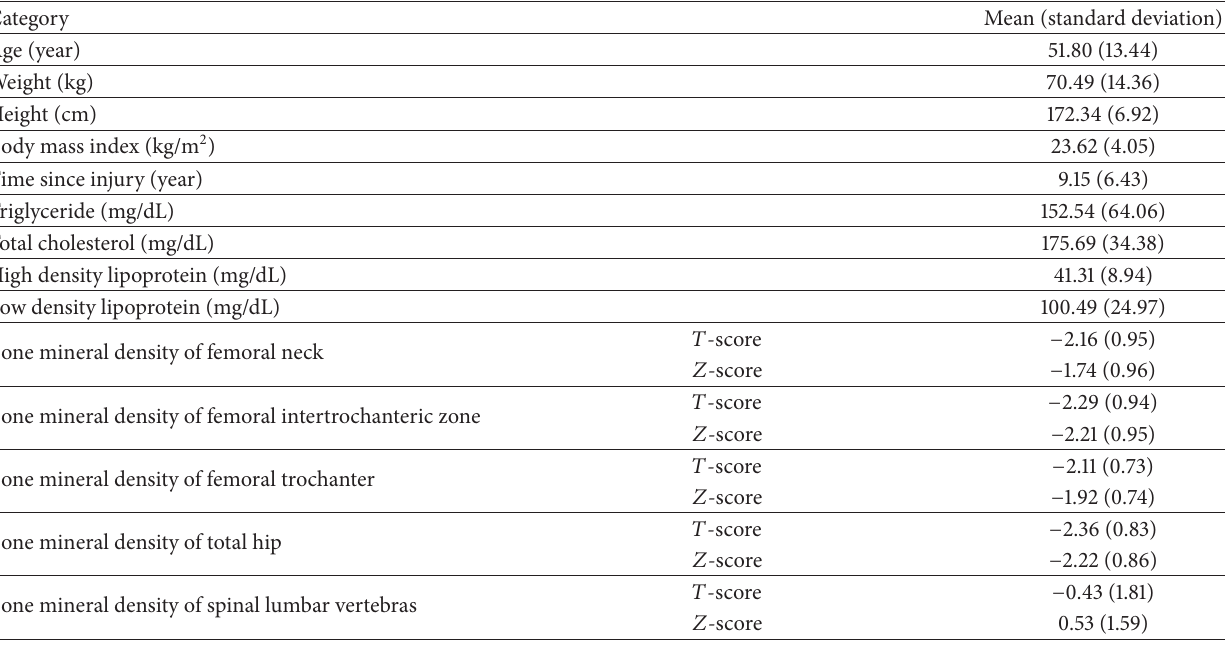
Table 2: The relationship between serum lipids and bone mineral density in male subjects with spinal cord injury. Category